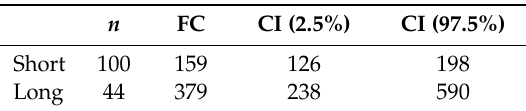
Table 5. FC (year) and confidence intervals (CI) for the period 1810–2010 for the short and long FC zones, calculated from Cox regressions using the TSF dataset.